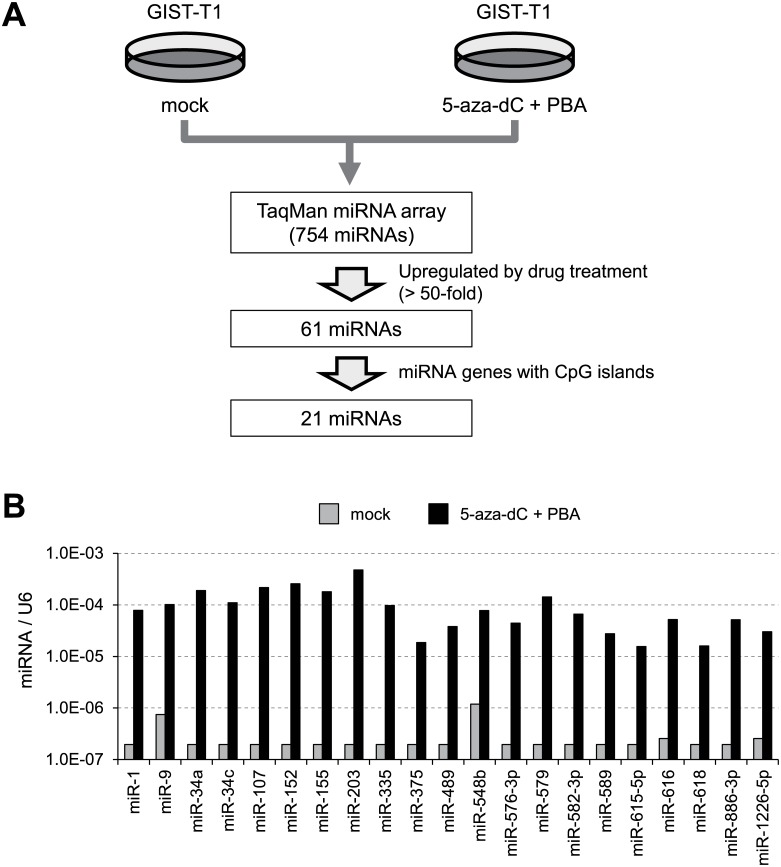
Identification of epigenetically silenced miRNAs in GIST-T1 cells.(A) Workflow of the screen to identify epigenetically silenced miRNAs. (B) Summarized TaqMan array results for 22 candidate miRNAs in GIST-T1 cells treated with or without 5-aza-dC plus PBA. Expression levels were normalized to that of U6 snRNA expression.